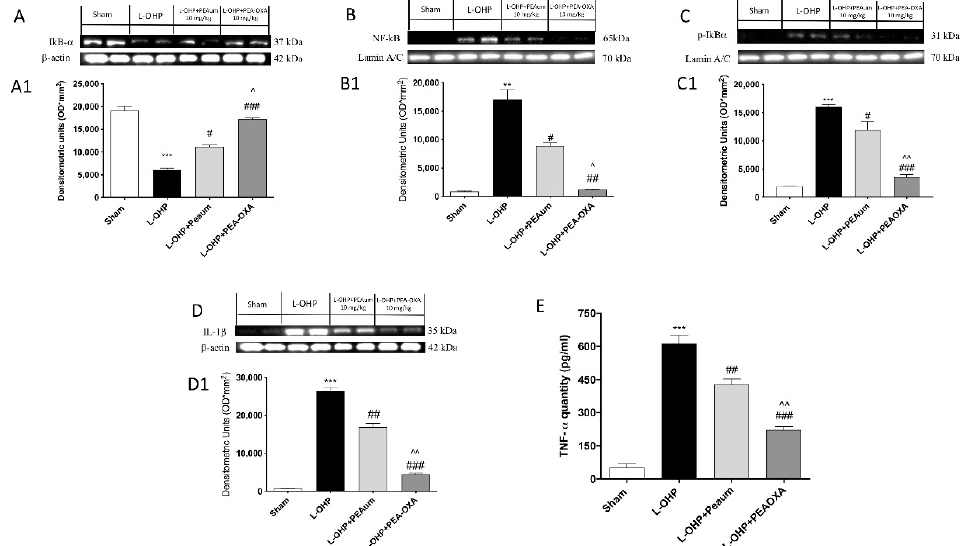
Figure 3. Effect of PEA-OXA on NF- κ B pathway and proinflammatory cytokines. The expression of I κ B- α , NF- κ B, p-I κ B- α , and IL-1 β was observed by Western blot analysis, in lumbar spinal cord, 25 days after L-OHP injections. We observed that L-OHP injections induced a decrease in I κ B- α expression compared to sham group ( A , A1 ), which was markedly